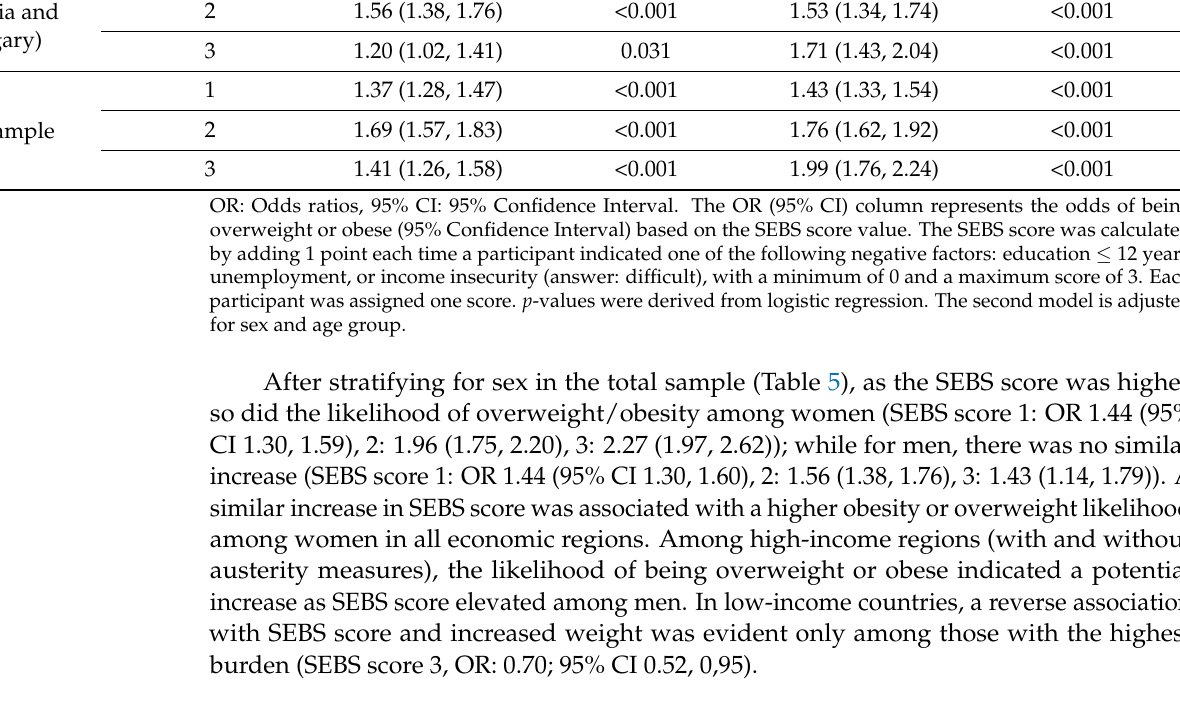
Table 5. SEBS score and the risk of being overweight or obese based on the country’s economic status, divided by